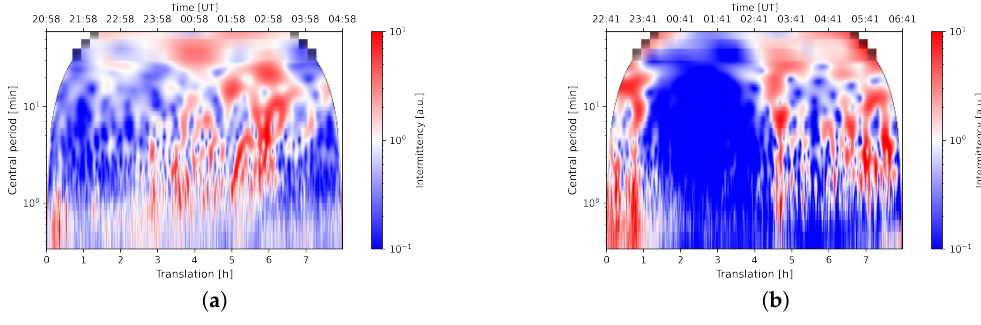
Figure 3. Intermittency for observations ( a ) L82655, ( b )